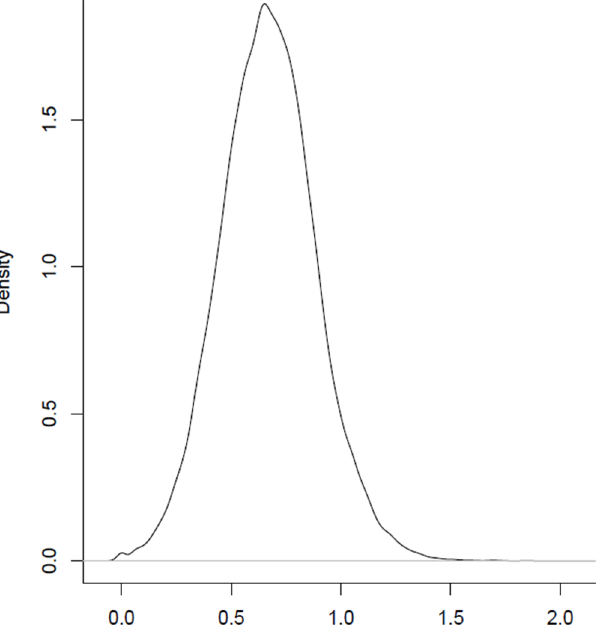
Fig 1. Distribution of CpG o/e ratio from all ORF containing contigs (80853) from P . elegans (mean